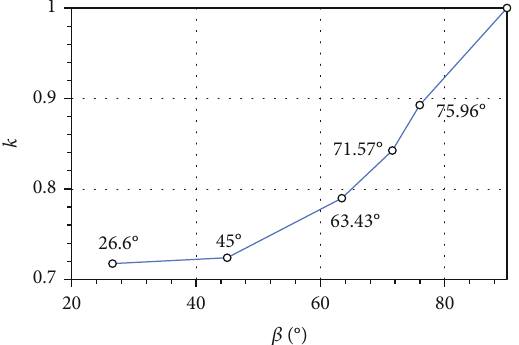
Figure 14: Variation in the bearing coe ffi cient of the ring foundation with di ff erent inclination angles.